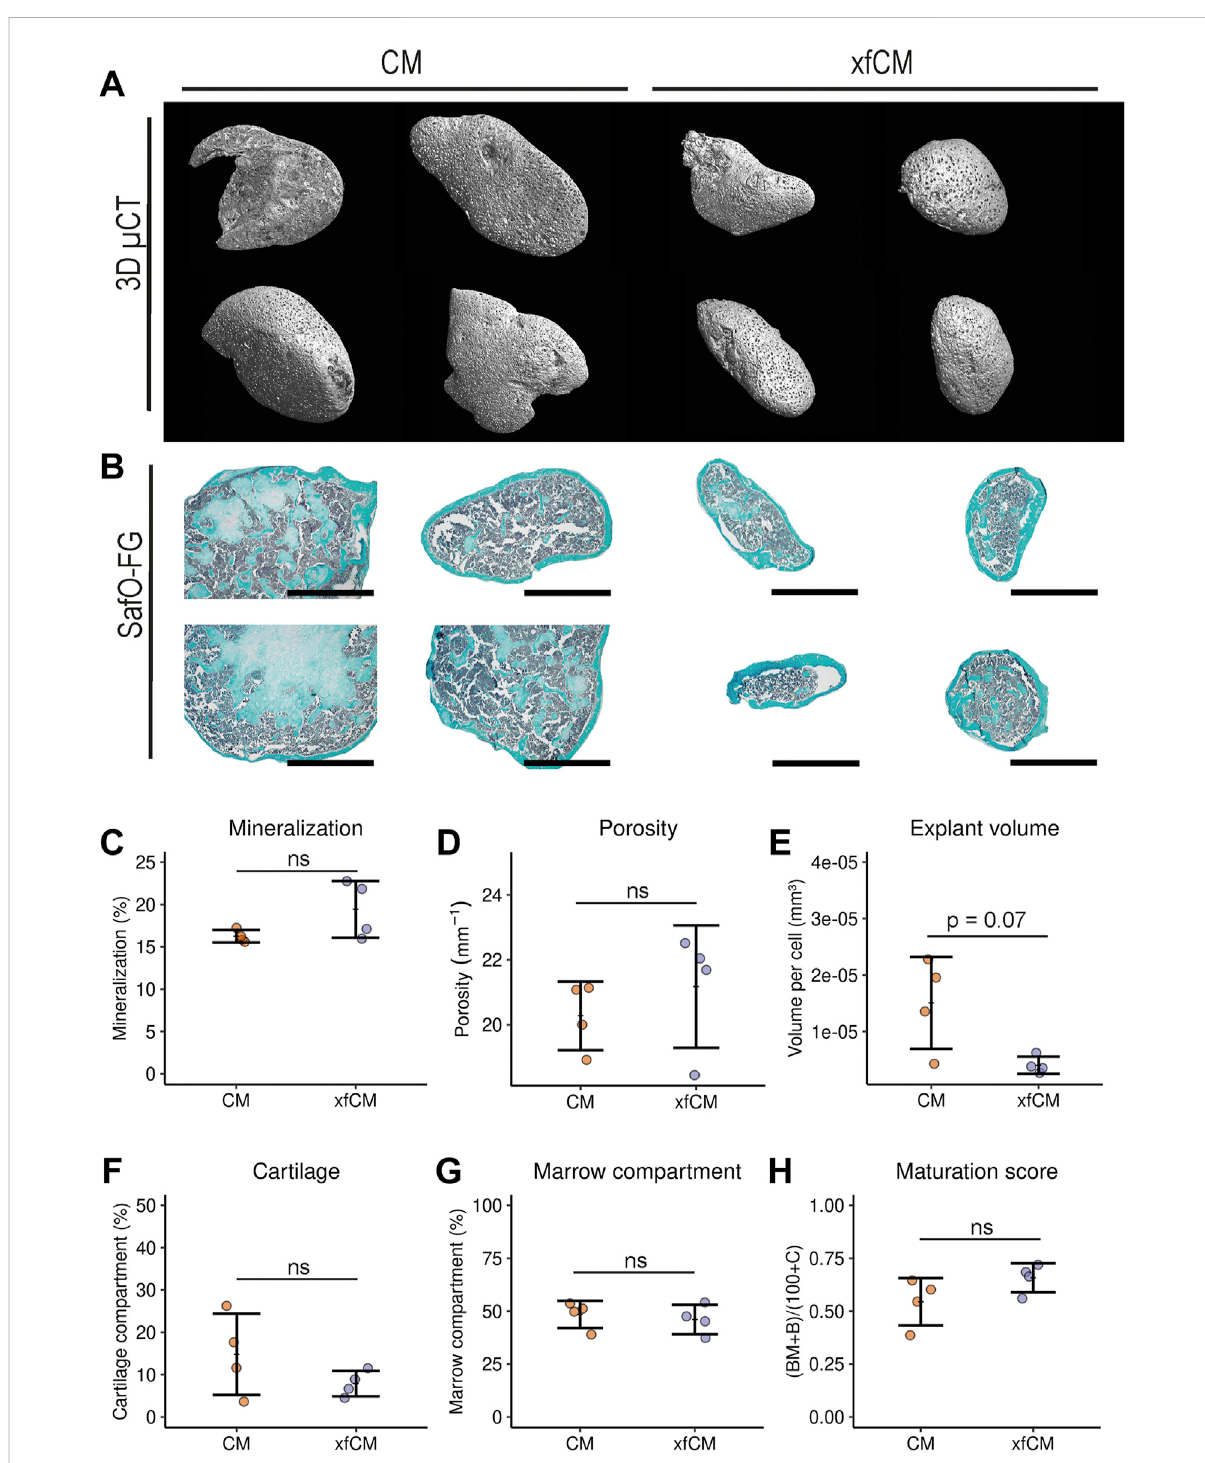
FIGURE 2 Ectopicimplantationsofbone-formingmicrotissues. (A) 3Drenderingsof4-weekectopicexplantsbynanocomputedtomography(nano-CT). (B) Saf O/FG/H histology staining of 4-week ectopic explants after decalci fi cation. (C – E) Percentage mineralization, porosity as 1/mineralized thickness and explant volume relative to DNA content derived from nano-CT quanti fi cation. (F,G) Percentage of cartilage tissue and bone marrow component per area as determined by SafO/FG/H histological staining. (H) Ossicle maturation score calculated from SafO/FG/H quanti fi cations. Data are presented as mean ± standard deviation. Scalebar = 1